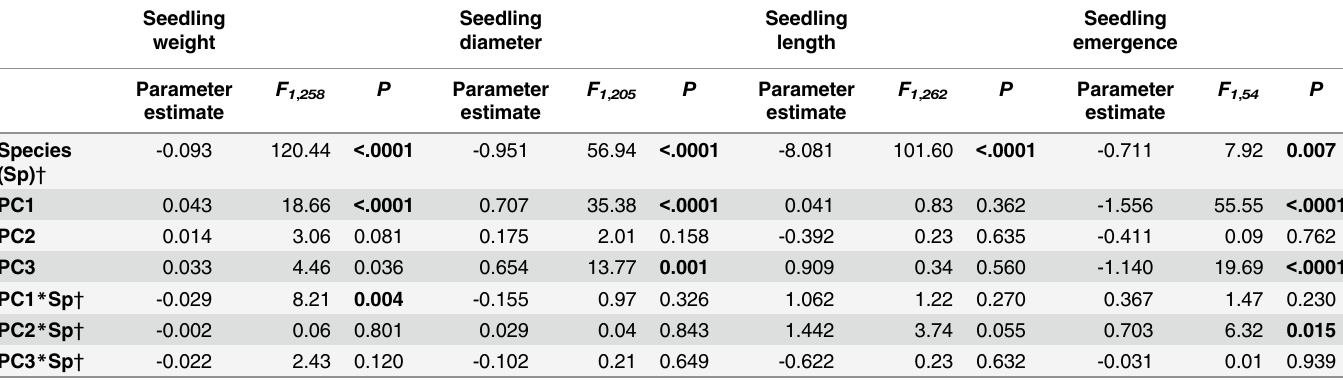
Table 4. Main results of the generalized linear mixed models testing the effects of principal components (based on substrate parameters), annual species, and their interactions on several seedling size components (length, diameter, weight) and the percentage of seedling emergence as well.